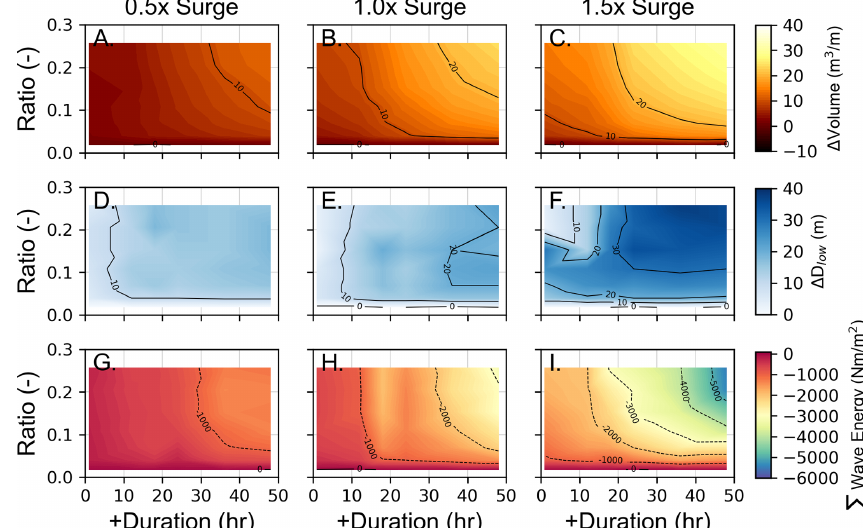
Figure 10. Relative dune erosion and wave impact energy for all heel-aligned simulations as a function of aspect ratio versus storm duration. The values from the equivalent simulations with the dune toes have been subtracted from the heel-aligned simulations to remove the influence from the varying beach widths in the heel-aligned simulations. Each column represents a different storm surge level (increasing left to right). These values represent a comparison relative to the toe-aligned simulation (where beach width is controlled for) such that the top row (a– c) shows the amount of volume loss prevented by the wider beach in these simulations, the middle row (d–f) shows the increase in dune toe progradation induced by the wider beach width, and the bottom row (g–i) shows the reduction in wave energy reaching the dune due to the wider (and thus lower sloping)